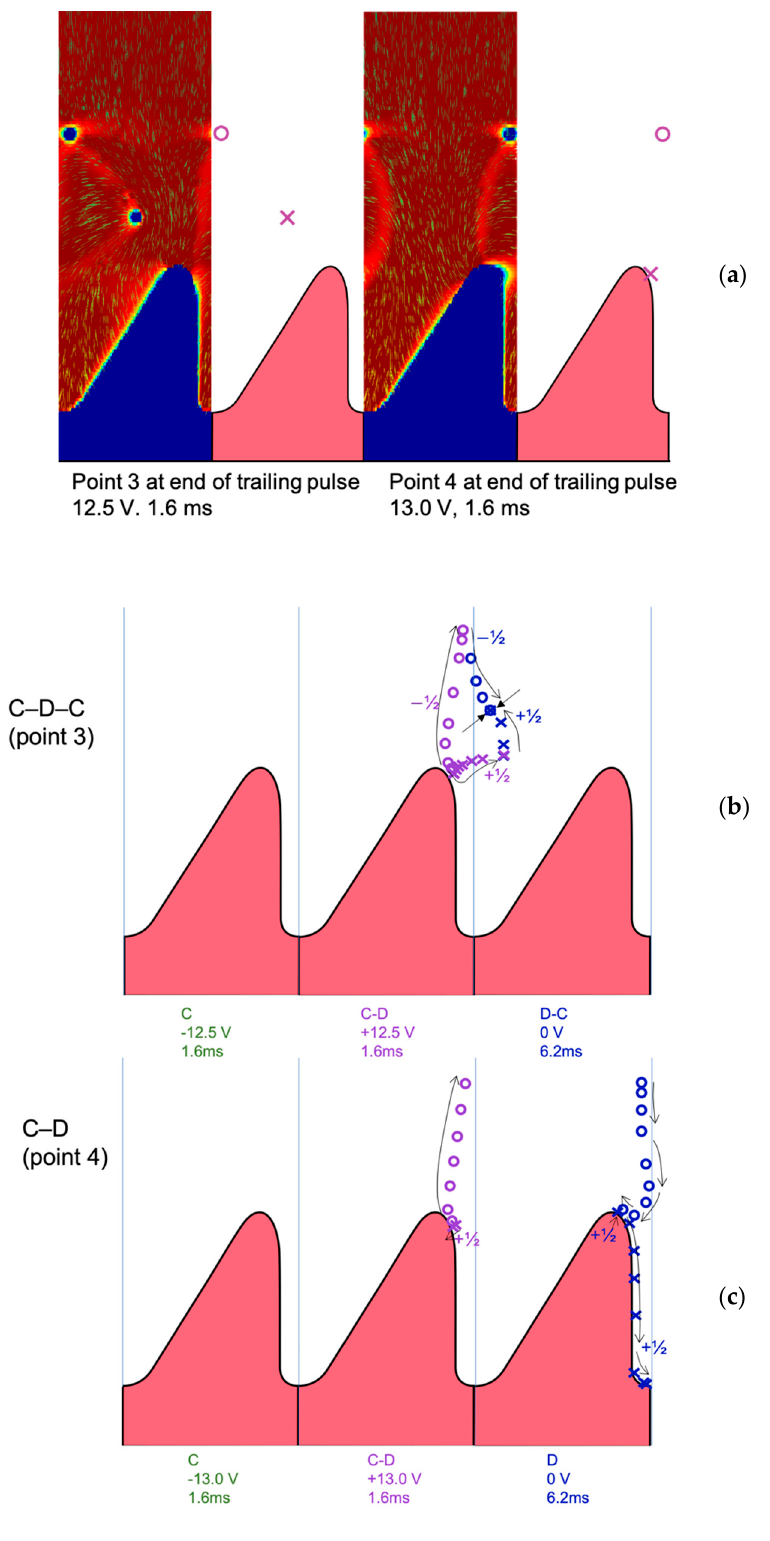
Figure 11. The anomalous latching mechanism either side of the threshold value. ( a ) Director and order profiles for the final frame of the trailing (positive) pulse. ( b ) Defect trajectories for point 3, below the latching threshold. ( c ) Defect trajectories for point 4 above the latching threshold.